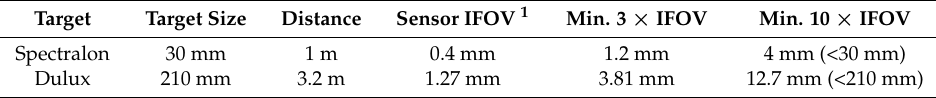
Table 5. Camera calibration target distances and IFOV to satisfy target size requirements.